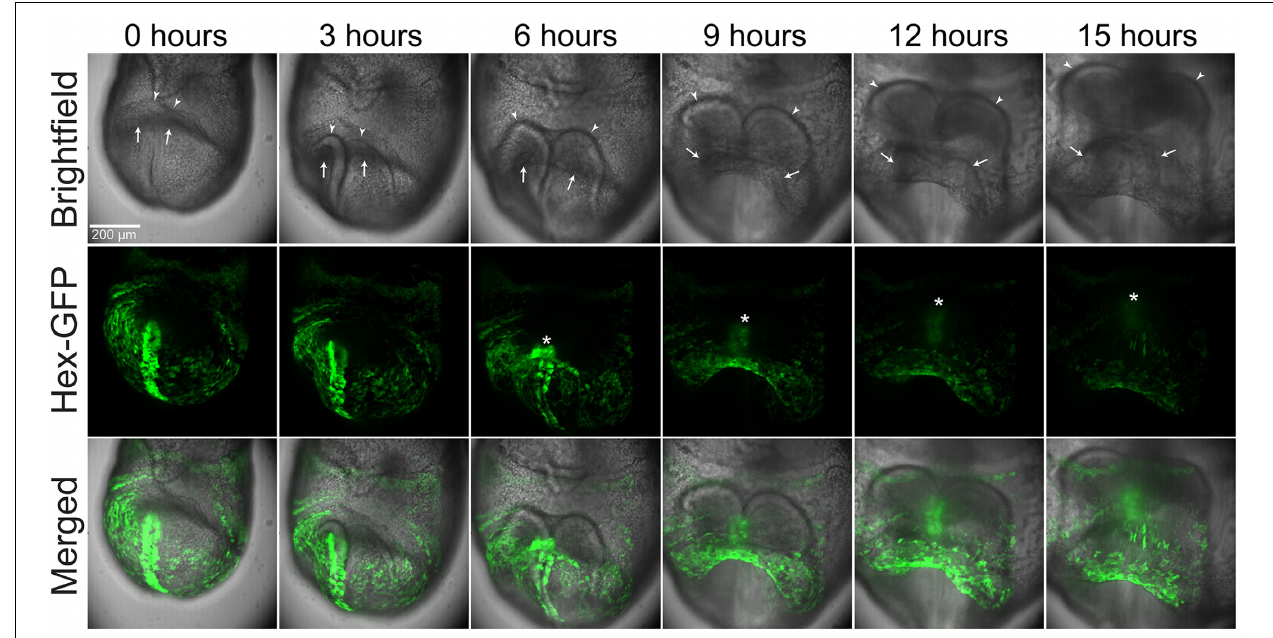
FIGURE 1 | Stills from a time-lapse sequence of a late E7.5 imaged by brightfield and GFP fluorescence microscopy. The egg cylinder is orientated with the distal end toward the bottom, the proximal end toward the top, and the forming rostral aspects facing the viewer. Hex-GFP labels